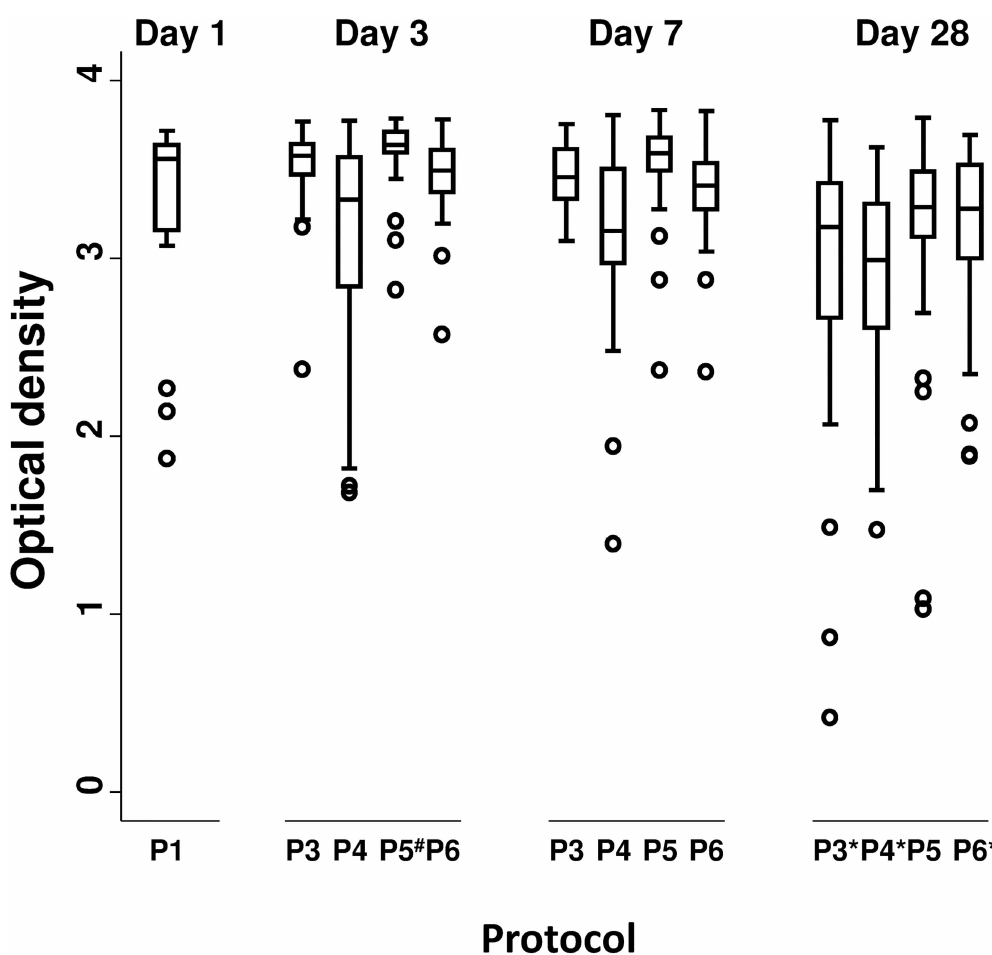
Fig 3. Boxplots of the optical density values obtained with the Erns-based Ag ELISA for different protocols at day 1 (reference), 3, 7 and 28. Legend:P1, P3, P4, P5 and P6: protocols appliedto the samples. P1 at day 1 is the reference protocol. # Optical density (protocol P5 at day 3) is significantly higher than the reference protocol. * Optical density (protocols P3, P4 and P6 at day 28) is significantly lower than the reference